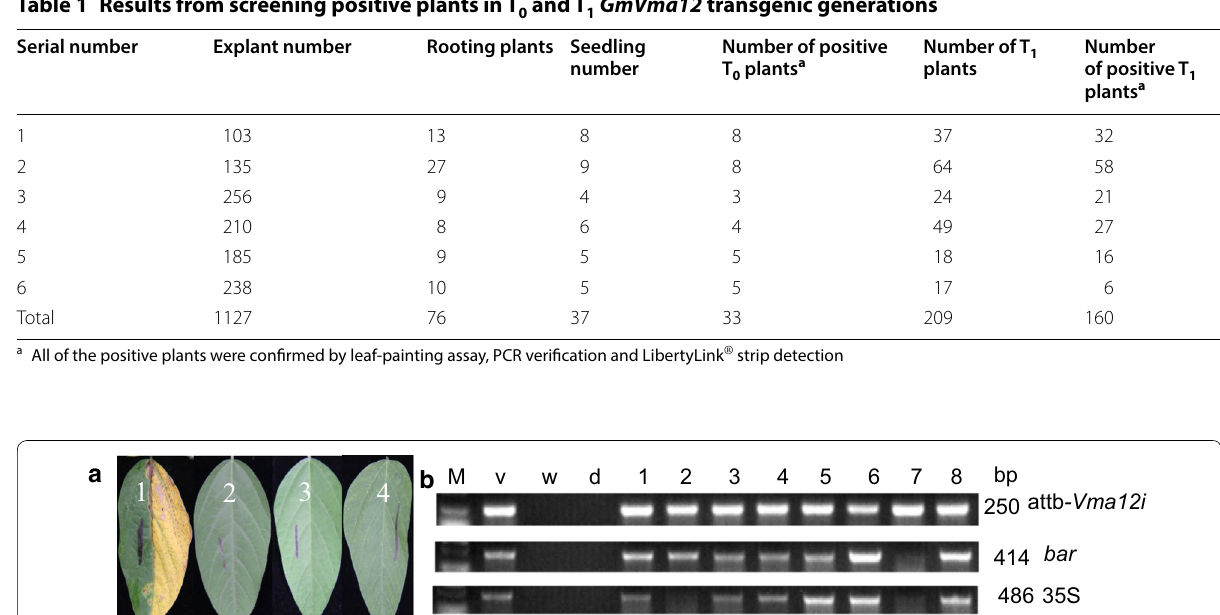
Table 1 Results from screening positive plants in T